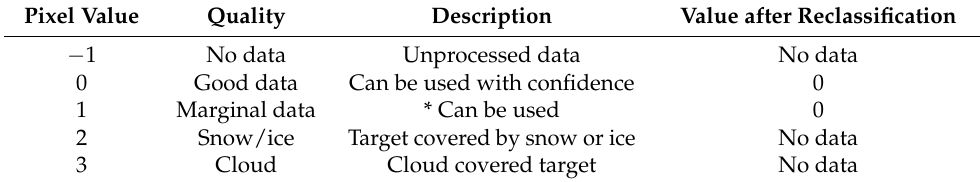
Table 2. Pixel reliability values for the EVI. Pixel Value Quality Description Value after Reclassification − 1 No data Unprocessed data No data 0 Good data Can be used with confidence 0 1 Marginal data * Can be used 0 2 Snow/ice Target covered by snow or ice No data 3 Cloud Cloud covered